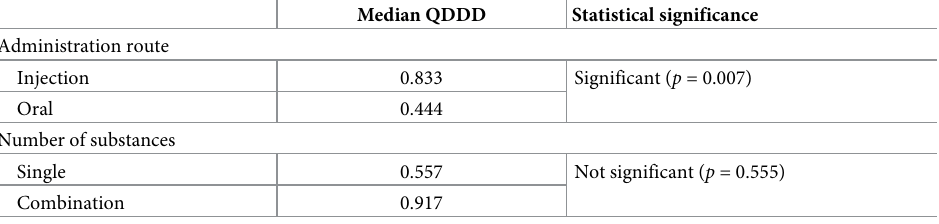
Table 4. Statistical evaluation of the calculated quotients QDDD of antimicrobial agents for use in pigs in Japan in relation to administration routes and the number of active ingredients contained in the preparation (Mann- Whitney U Test).